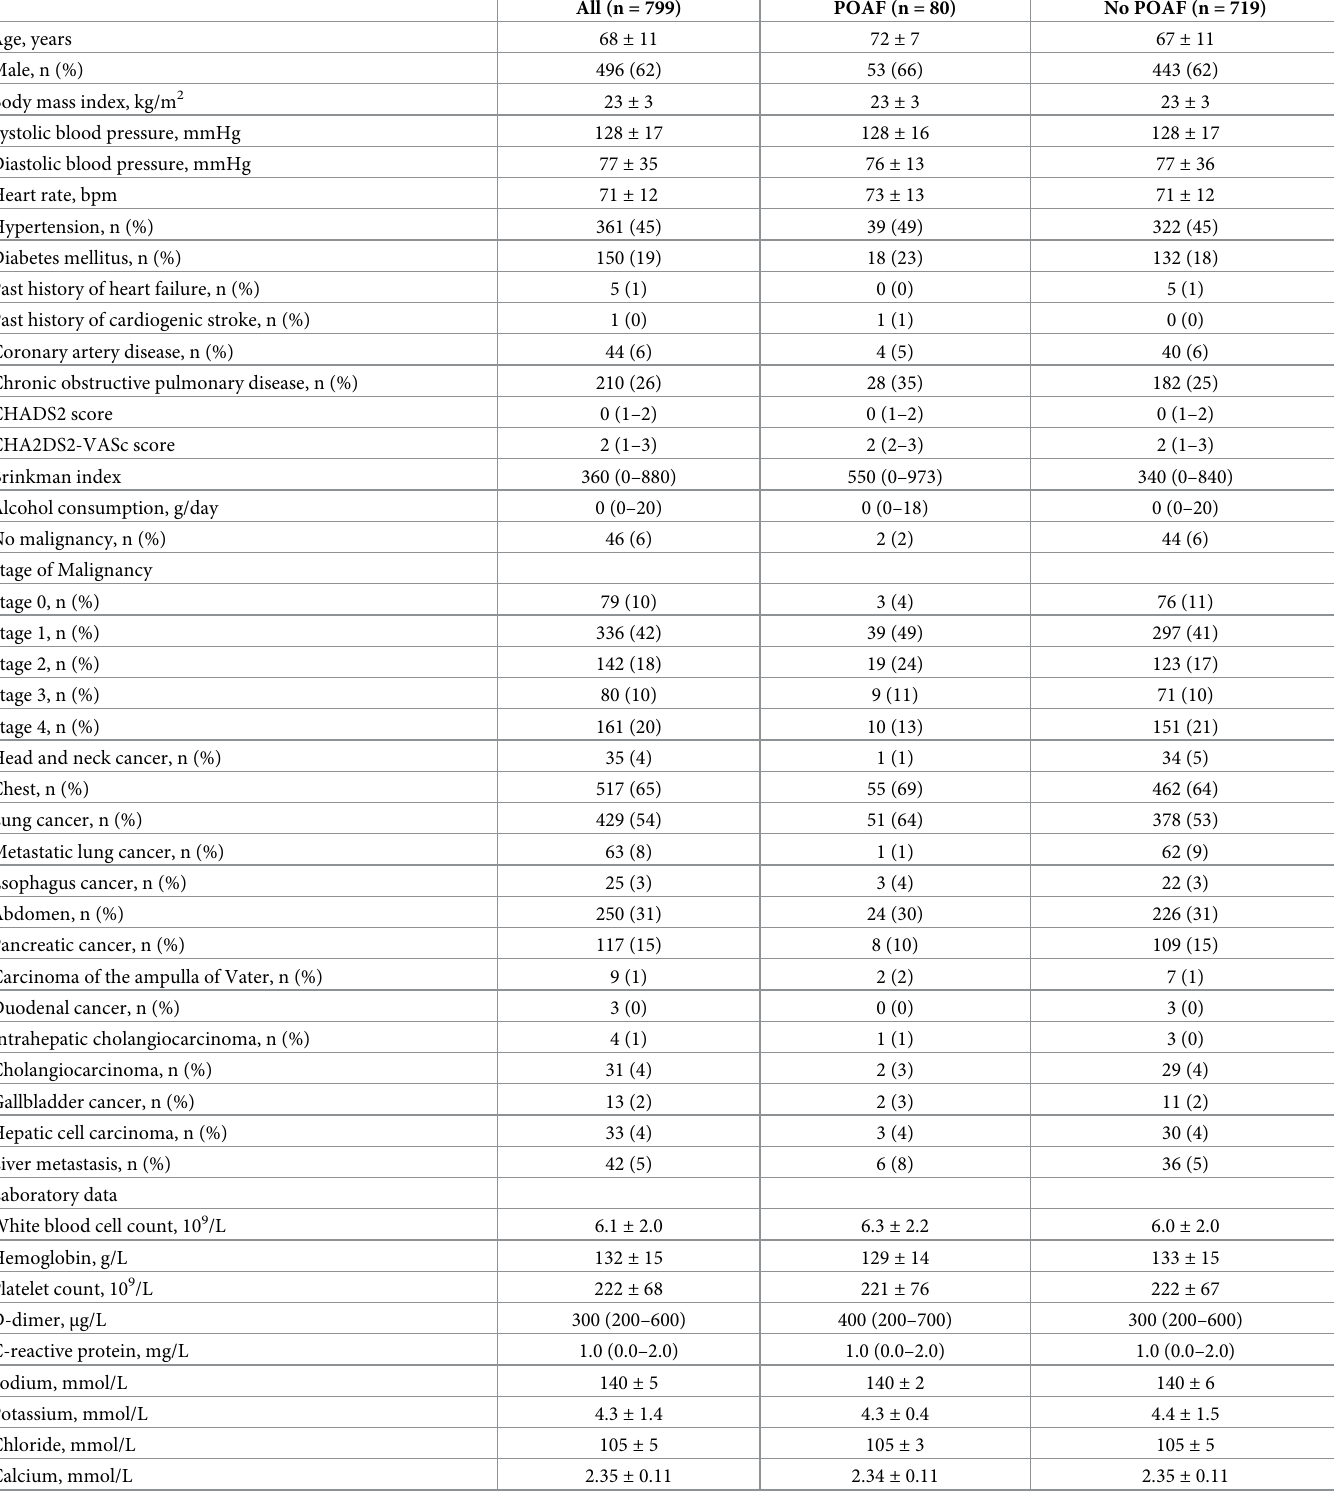
Table 1. Patient